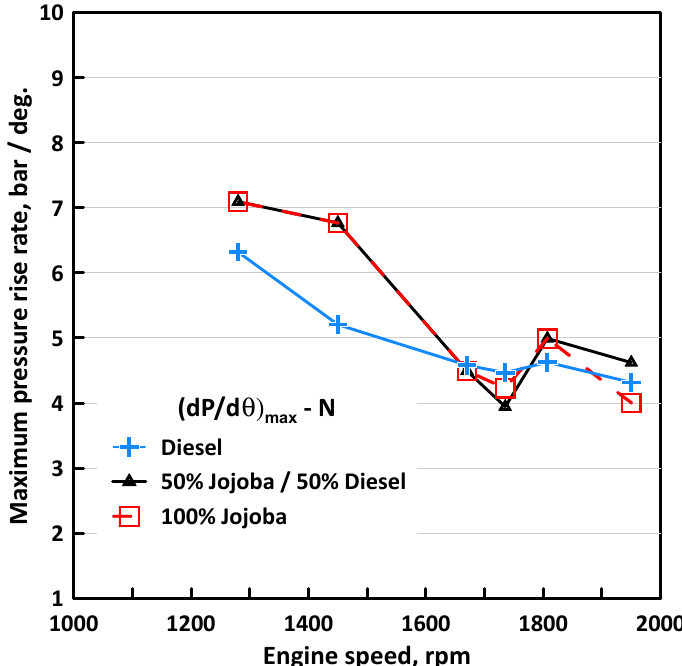
Figure 12. Effect of engine speed on the maximum combustion pressure rise rate for the three fuels used.